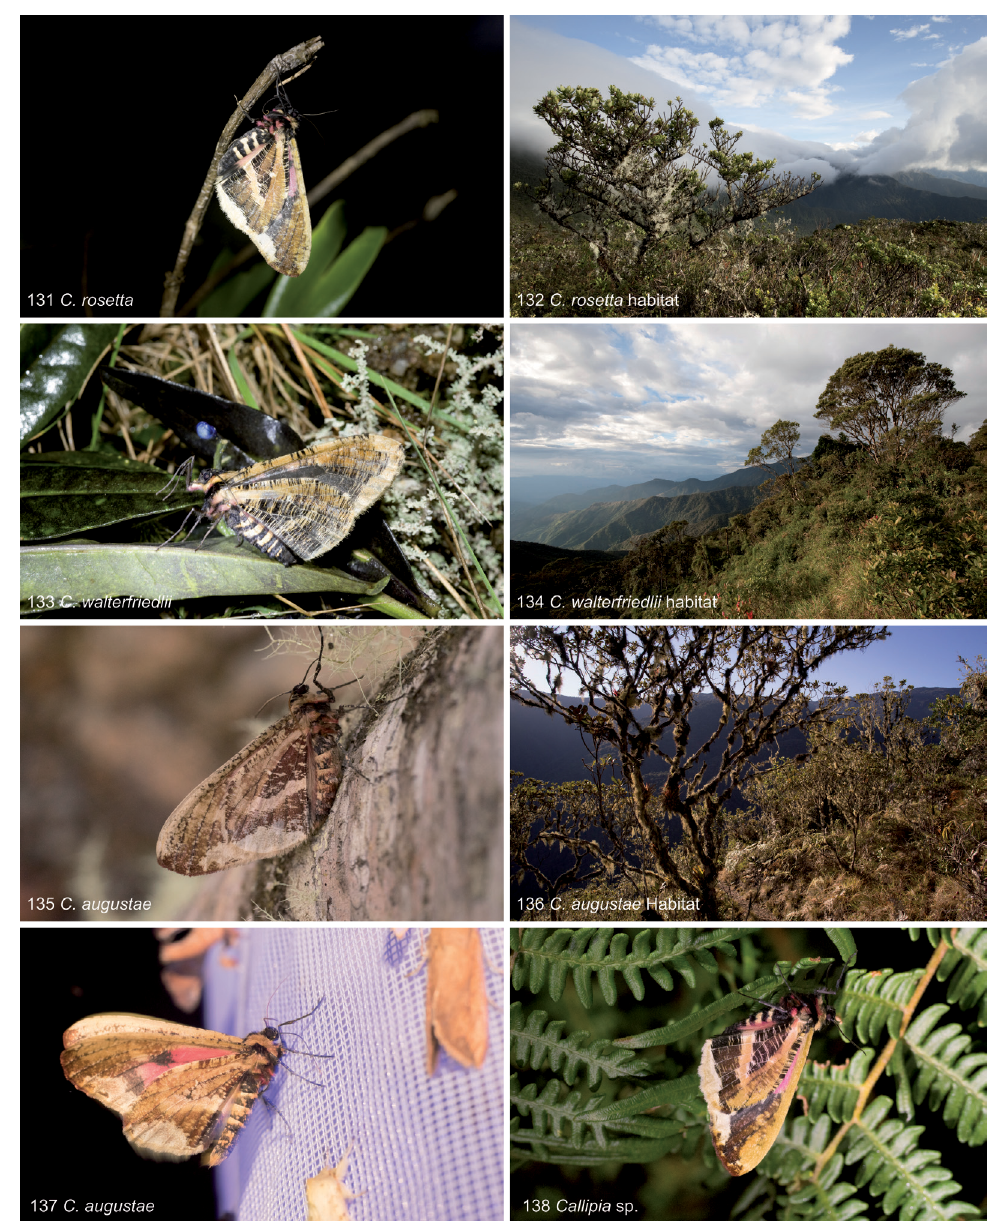
Figs 131–138. Living specimens and habitats. 131 . Callipia rosetta Thierry-Mieg, 1904, ♂, Ecuador, Loja province, Podocarpus National Park, Cajanuma, 2897 m, 26 Mar. 2011. The specimen was attracted to light and benumbed. 132 . Elfin forests are a habitat of C. rosetta Thierry-Mieg, 1904 and C. walterfriedlii sp. nov., Ecuador, Loja province, Podocarpus National Park, Cajanuma, 3000 m, 30 Jan. 2013. 133 . C. walterfriedlii sp. nov., ♀, Ecuador, Loja province, Podocarpus National Park, Cerro Toledo, 2938 m, 27. Feb. 2013. The specimen was attracted to light and benumbed. 134 . Habitat (elfin forest) of C. walterfriedlii sp. nov. at Cerro Toledo. 135 . C. augustae sp. nov., ♂, Peru, Cusco province, Wayqecha station, 2900 m, 26 Aug. 2016. The specimen was collected at night, trapped, photographed and released the next morning. 136 . Habitat of C. augustae sp. nov. and Callipia sp. near Wayqecha station. 137 . C. augustae sp. nov., ♂, Peru, Cusco province, road Wayqecha–Pillcopata, 2284 m, 23 Aug. 2016. The specimen was attracted to UV light and tried to take up fluid (see proboscis). 138 . Callipia sp. at Wayqecha station, 4 Sep. 2016. This specimen was attracted to UV light, but escaped into the vegetation when